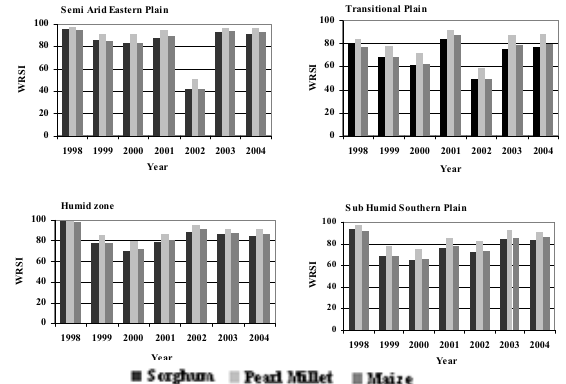
Fig. 5. Inter-annual variation in WRSI of rain-fed crops